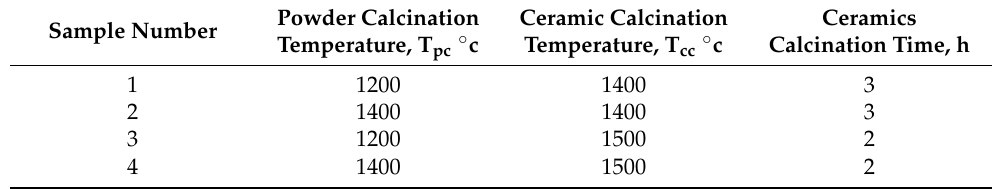
Table 1. Modes of preparation of Gd 0.96 Eu 0.01 Sm 0.01 Tb 0.01 Er 0.01 Nb 0.9 Ta. 0.1 O 4 ceramic